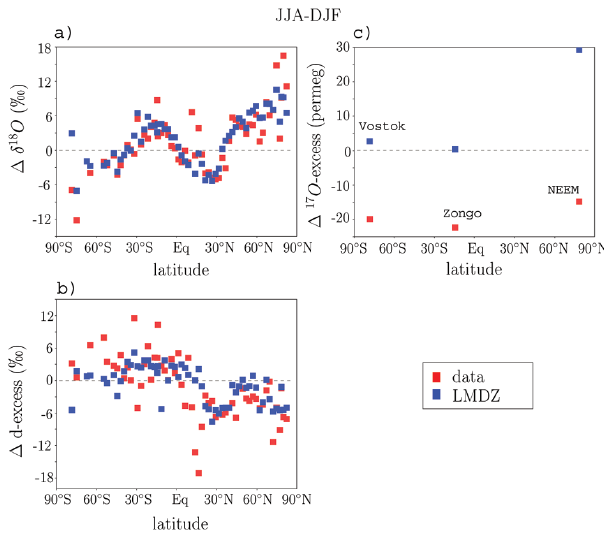
Fig. 5. Same as Fig. 4 but for JJA-DJF variations.